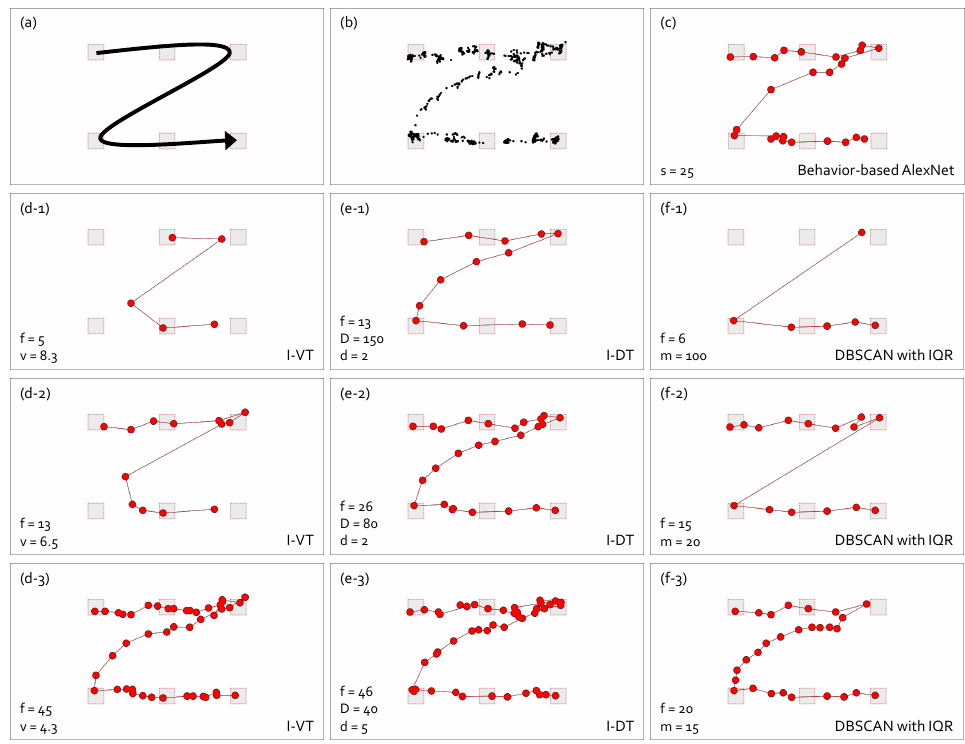
Figure 11. Comparison of scanpath visualizations with the eye movement while reading according to the gaze-parsing algorithms. ( a ) The visual stimulus with the eye movement task of an observer. The observer slowly moves the eye to the end without pausing the eye movement. ( b ) The raw gaze points. ( c ) The scanpath visualization with the behavior-based gaze data processing method using AlexNet. The scanpath visualizations with I-VT in ( d-1 – d-3 ), I-DT in ( e-1 - e-3 ), and DBSCAN with IQR in ( f-1 – f-3 ) are